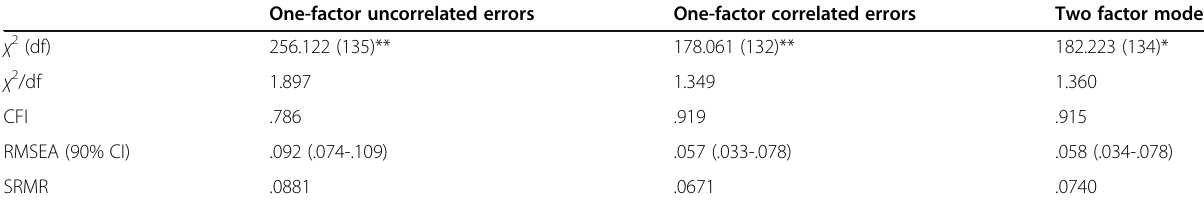
Table 1 Indices for confirmatory factor analysis of the